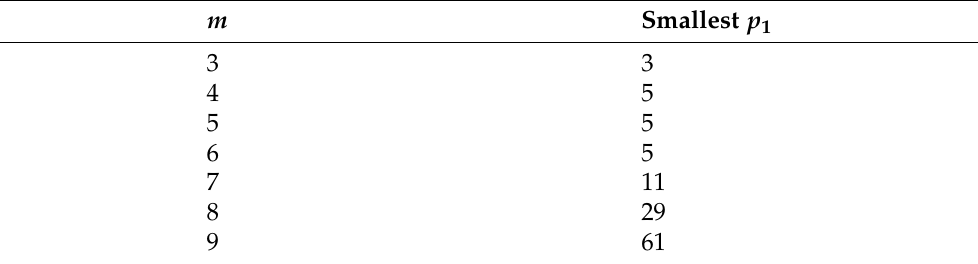
Table 4. Smallest p 1 for given m for which maximally idempotent integers are known.